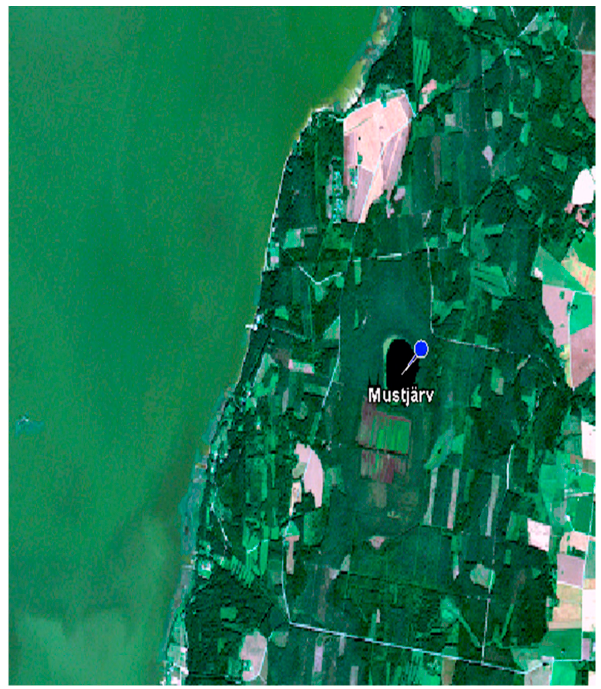
Figure 9. Fragment of a Sentinel-2 image with a small fraction of Lake Võrtsjärv (left half of the image) and an extreme CDOM-rich Lake Mustjärv.